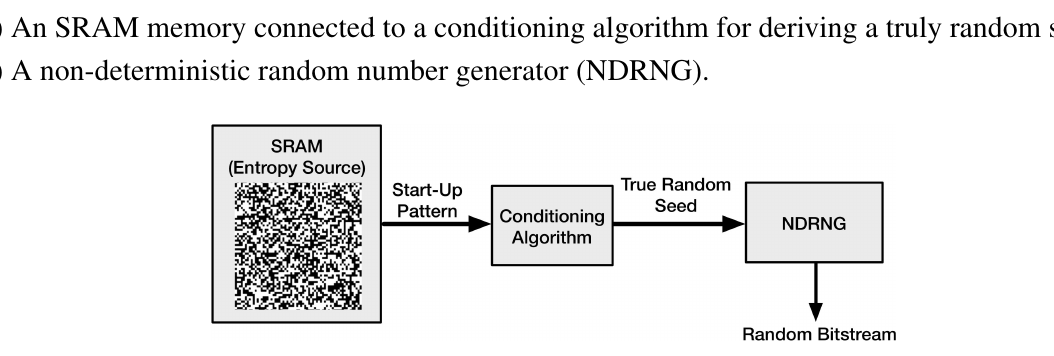
Figure 2. The architecture of